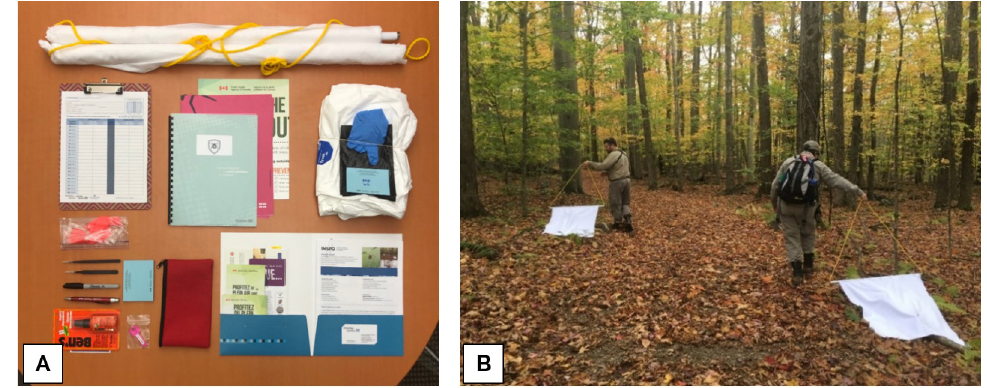
Fig 1. Reference pictures of the project. Photographs depict (A) the content of the ambassador training kit provided at workshop (bilingual workbook, outreach material, USB key with project forms and additional material, informed consent, and the necessary tools for tick sampling, including white flannels, fine-tipped tweezers, insect repellent, 2mL ethanol-vials, Tyvek 1 suits and personal protection equipment), and ( B ) the flannel-dragging session conducted by newly-formed ambassadors during a workshop’s fieldwork